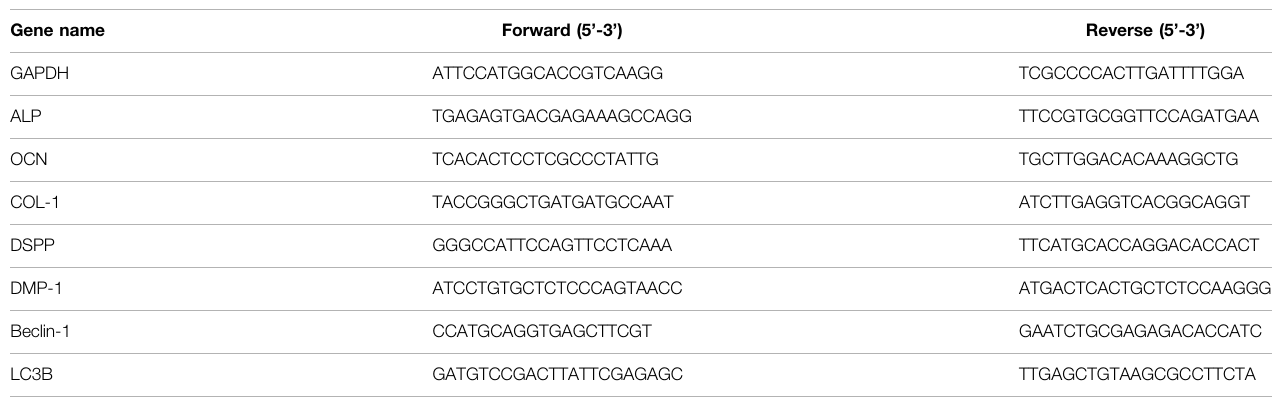
TABLE 1 | The primers for the reference genes.